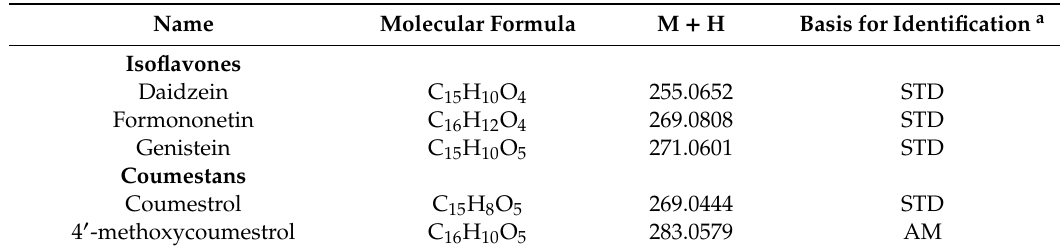
Table 5. Phytoestrogens from pasture legume species identified in this study by LC-MS-QToF in positive ionization